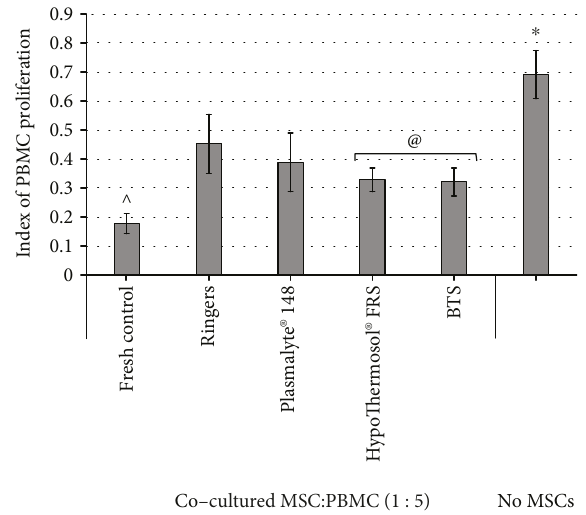
Figure 4: Proliferation of PHA-stimulated PBMC in coculture with MSCs before and after 72 hrs hypothermic storage in di ff erent preservation solutions. ∗ Data is signi fi cantly di ff erent compared to MSC: PBMC coculture groups ( p < 0 05 ); @ data is signi fi cantly di ff erent compared to Ringer ’ s solution ( p < 0 05 ); ^ values are signi fi cantly di ff erent compared to all coculture groups after 72 hrs of storage ( p < 0 05